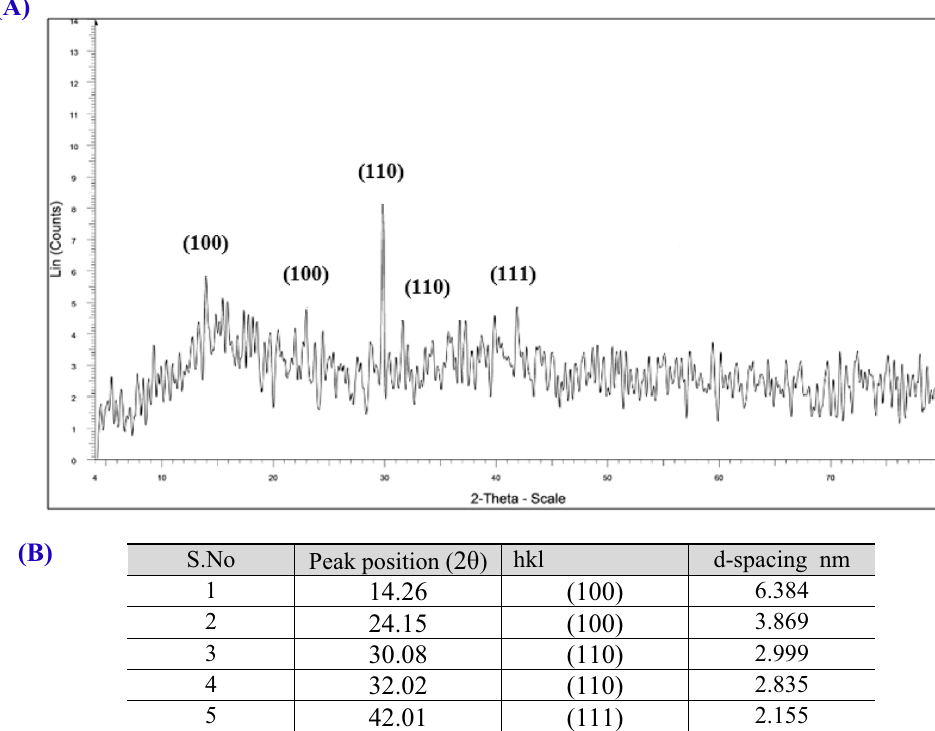
Figure 5. X-Ray Diffraction pattern of gelatin capped-silver nanoparticles bio synthesized by using Oscillatoria limnetica extract ( A and B ).